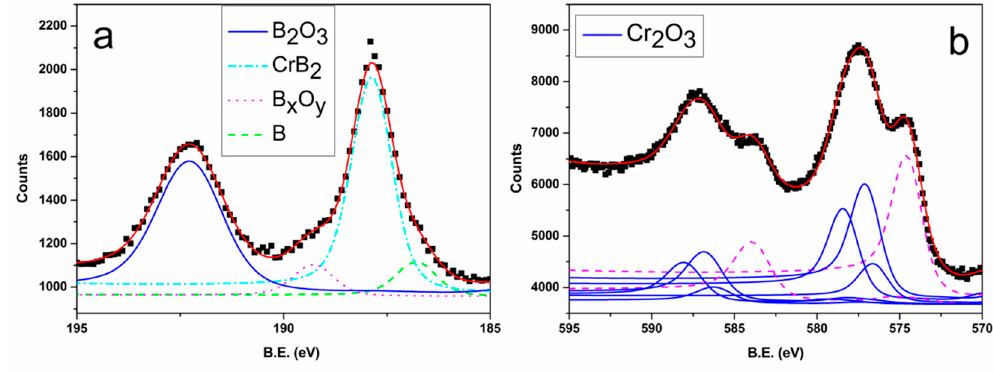
Figure 5. XPS spectra of a film deposited at a substrate temperature of 500 °C from a target with a Cr- B molar ratio of 1:4; ( a ) B 1 s region, and( b ) Cr 2 p region. The black points represent the experimental data and the red line represents the data fitting.